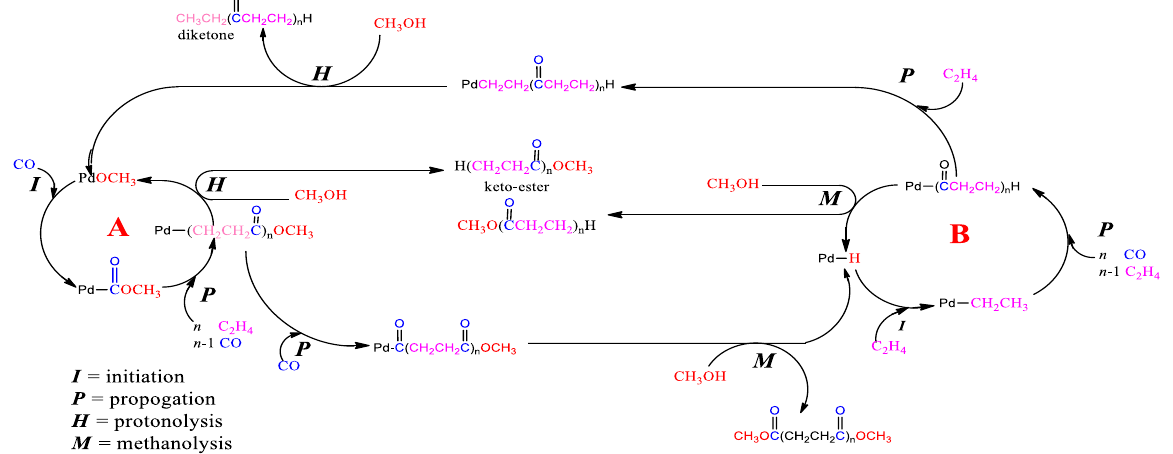
Figure 1. Commercial routes to methyl methacrylate and related acrylics.